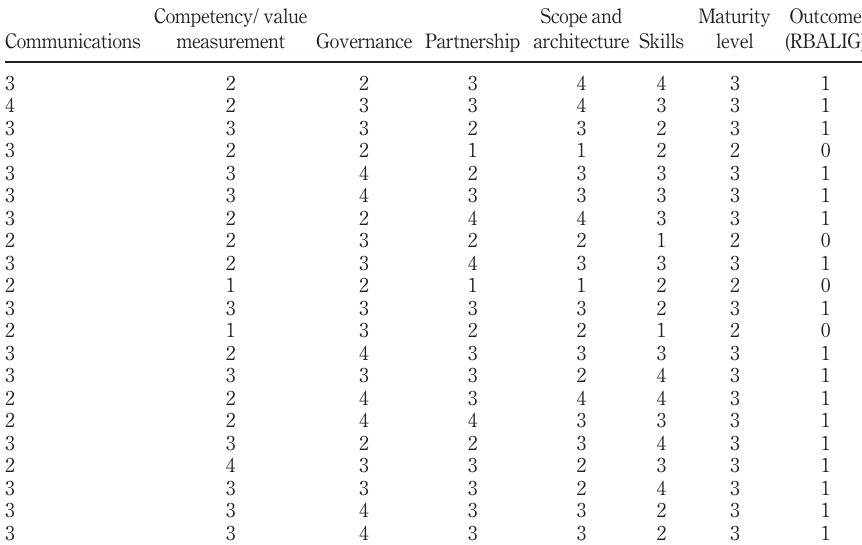
Table IV. RPA – business alignment maturity evaluation